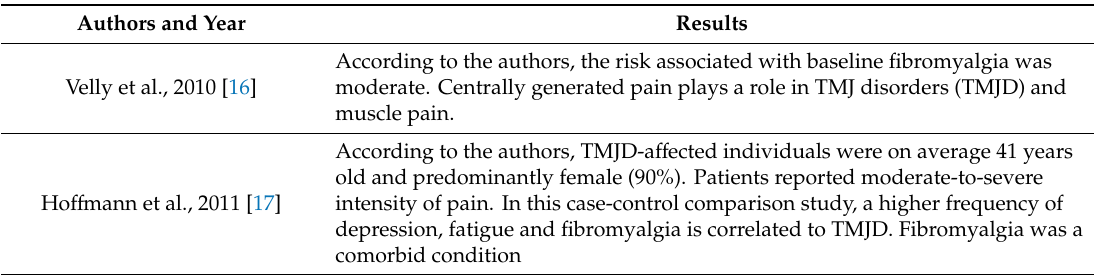
Table 4. Synthesis of results according to Section